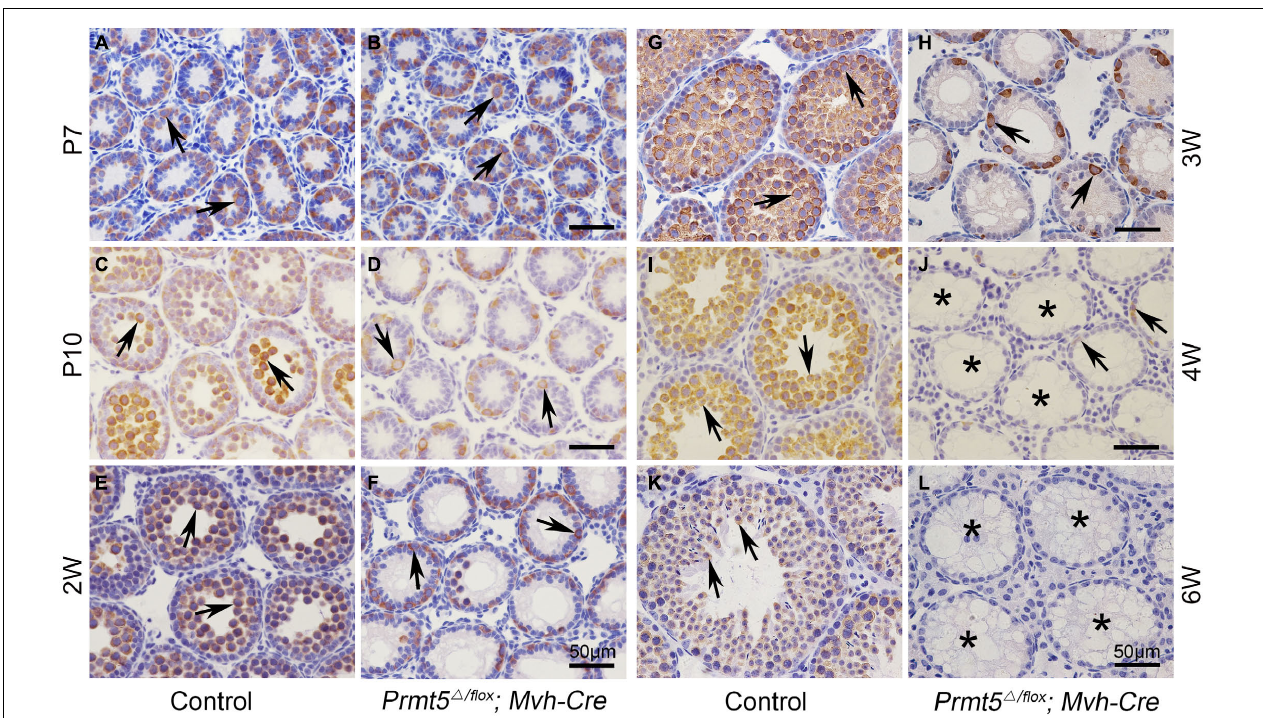
FIGURE 2 | Germ cells from Prmt5 (cid:49)/ flox ;Mvh-Cre mice are gradually lost from P10. The germ cells in control and Prmt5 (cid:49)/ flox ;Mvh-Cre mice were labeled with an anti-MVH antibody. MVH-positive germ cells were observed in both control [ (A) , black arrows] and Prmt5 (cid:49)/ flox ;Mvh-Cre mice [ (B) , black arrows] at P7, and no difference was noted. The number of germ cells in Prmt5 (cid:49)/ flox ;Mvh-Cre mice [ (D) , black arrows] was significantly reduced at P10 compared to that observed in control mice [ (C) , black arrows]. The number of germ cells was significantly increased from 2 to 6 weeks in control mice [ (E,G,I,K) , black arrows]. In contrast, the number of germ cells in Prmt5 (cid:49)/ flox ;Mvh-Cre mice was gradually reduced from 2 to 4 weeks [ (F,H,J) , black arrows] and was completely absent at 6 weeks of age [ (L) ,